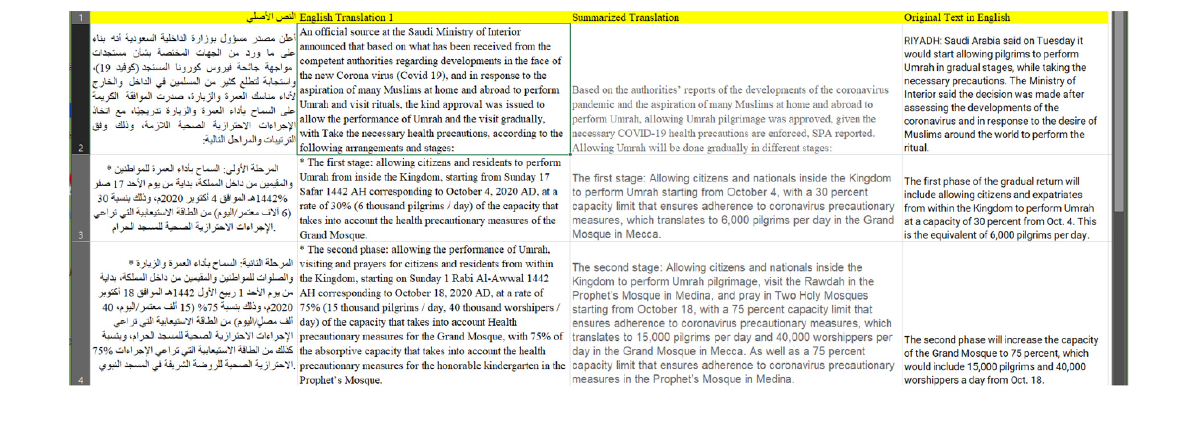
FIGURE 1 | Example of a monolingual comparable corpus. TABLE 1 | Exact and fuzzy matches extracted from a monolingual